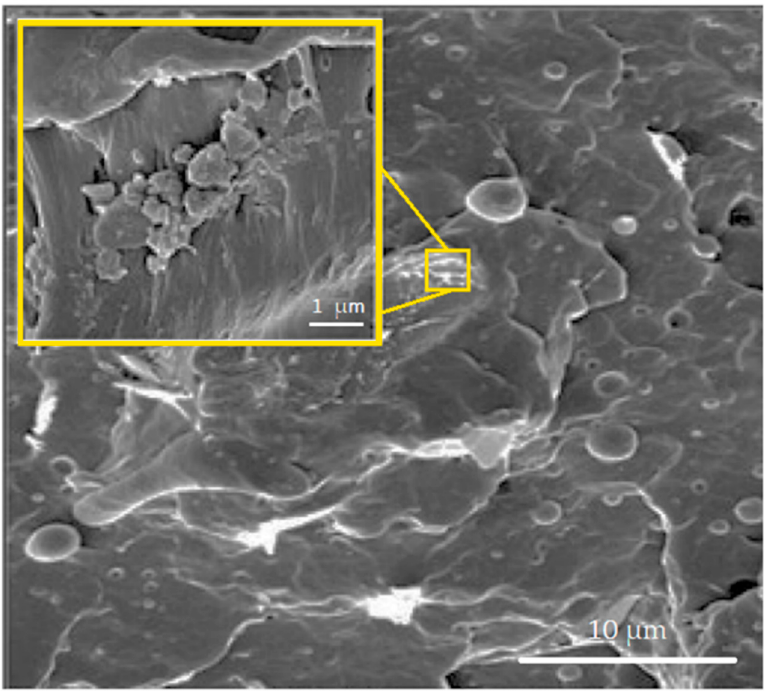
Figure 7. SEM micrograph of bagasse flour/PP incorporated with 1 wt % of GO filler. Inset displays the agglomeration of the filler in the fractured surface. Adapted from [71].